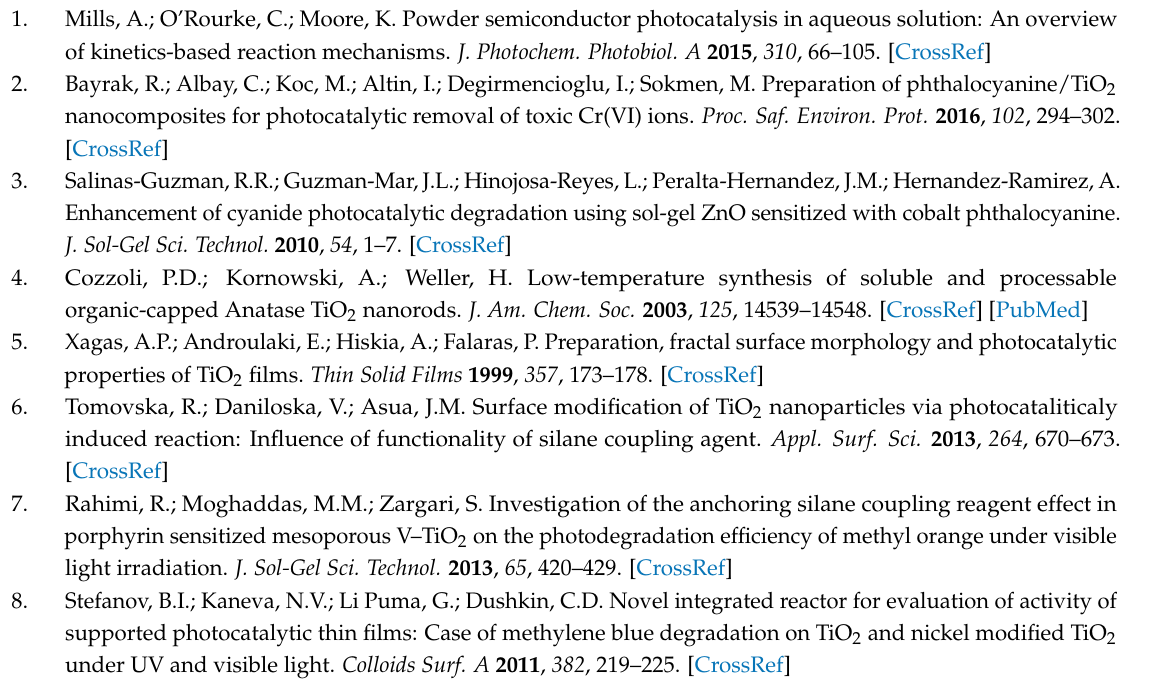
Figure S1: The emission spectrum of the LED projectors (characteristics can be found on the producer’s website: